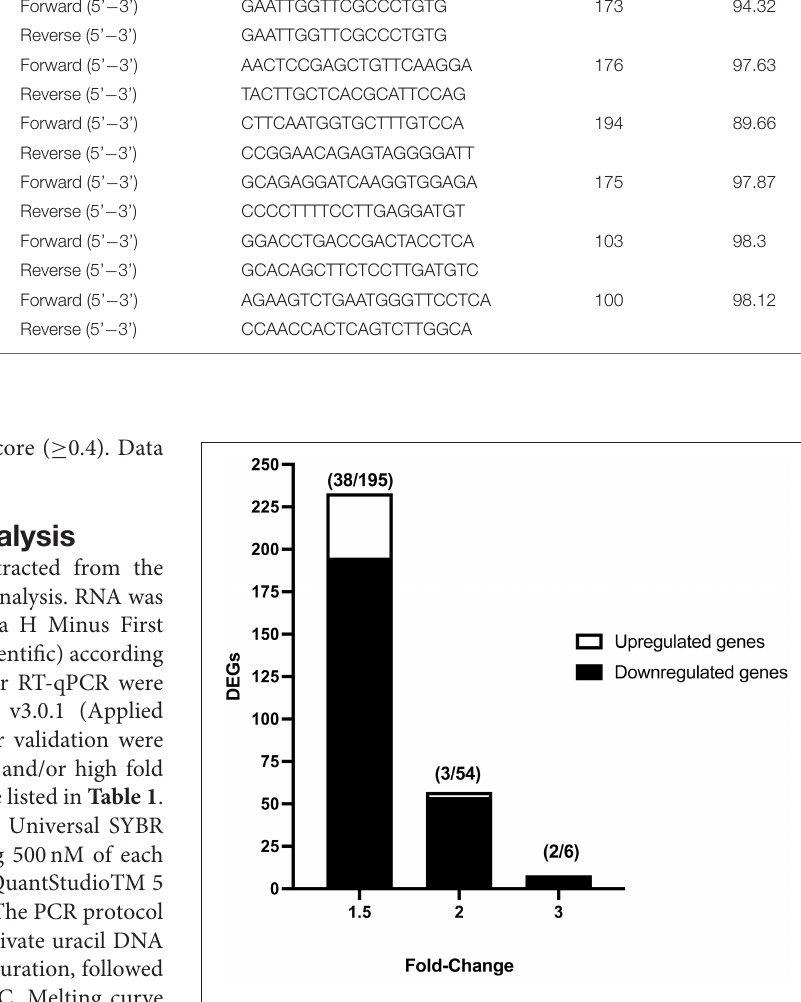
FIGURE 1 | Number of differentially expressed genes (DEGs) in vitrified-warmed morulae compared to the fresh control embryos. DEGs were identified from transcriptome analysis using different fold-change values (1.5, 2, and 3) and an unadjusted P value of 0.05. Numbers in parentheses indicate the number of up- and downregulated